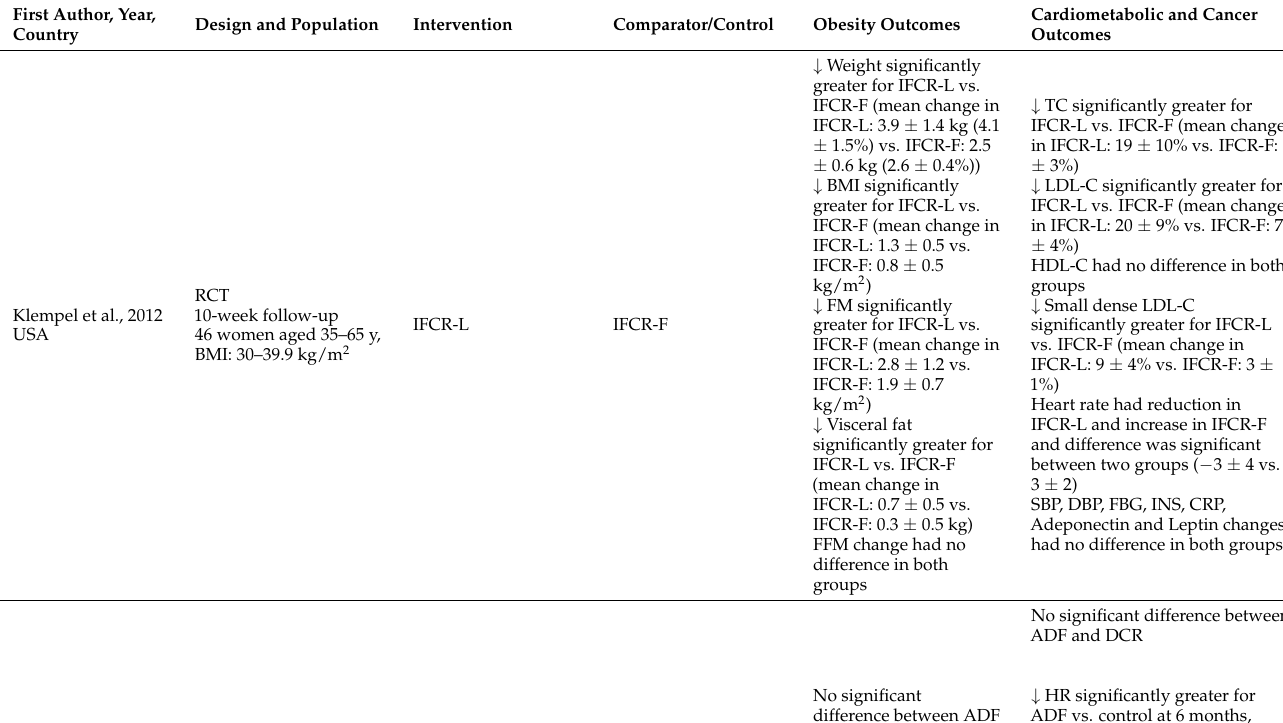
Table 4. Summary of studies with intermittent fasting diet for weight loss, obesity and cardiometabolic